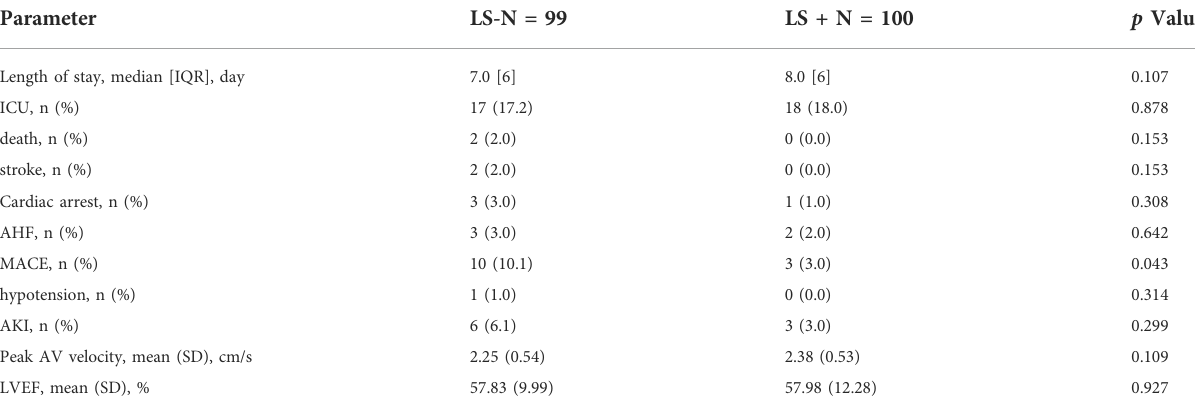
TABLE 2 In-hospital outcomes and echocardiographic